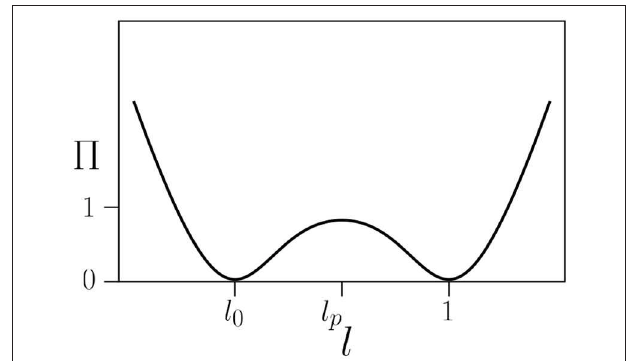
FIGURE 2 | Energy function Equation (1) of a bistable element.